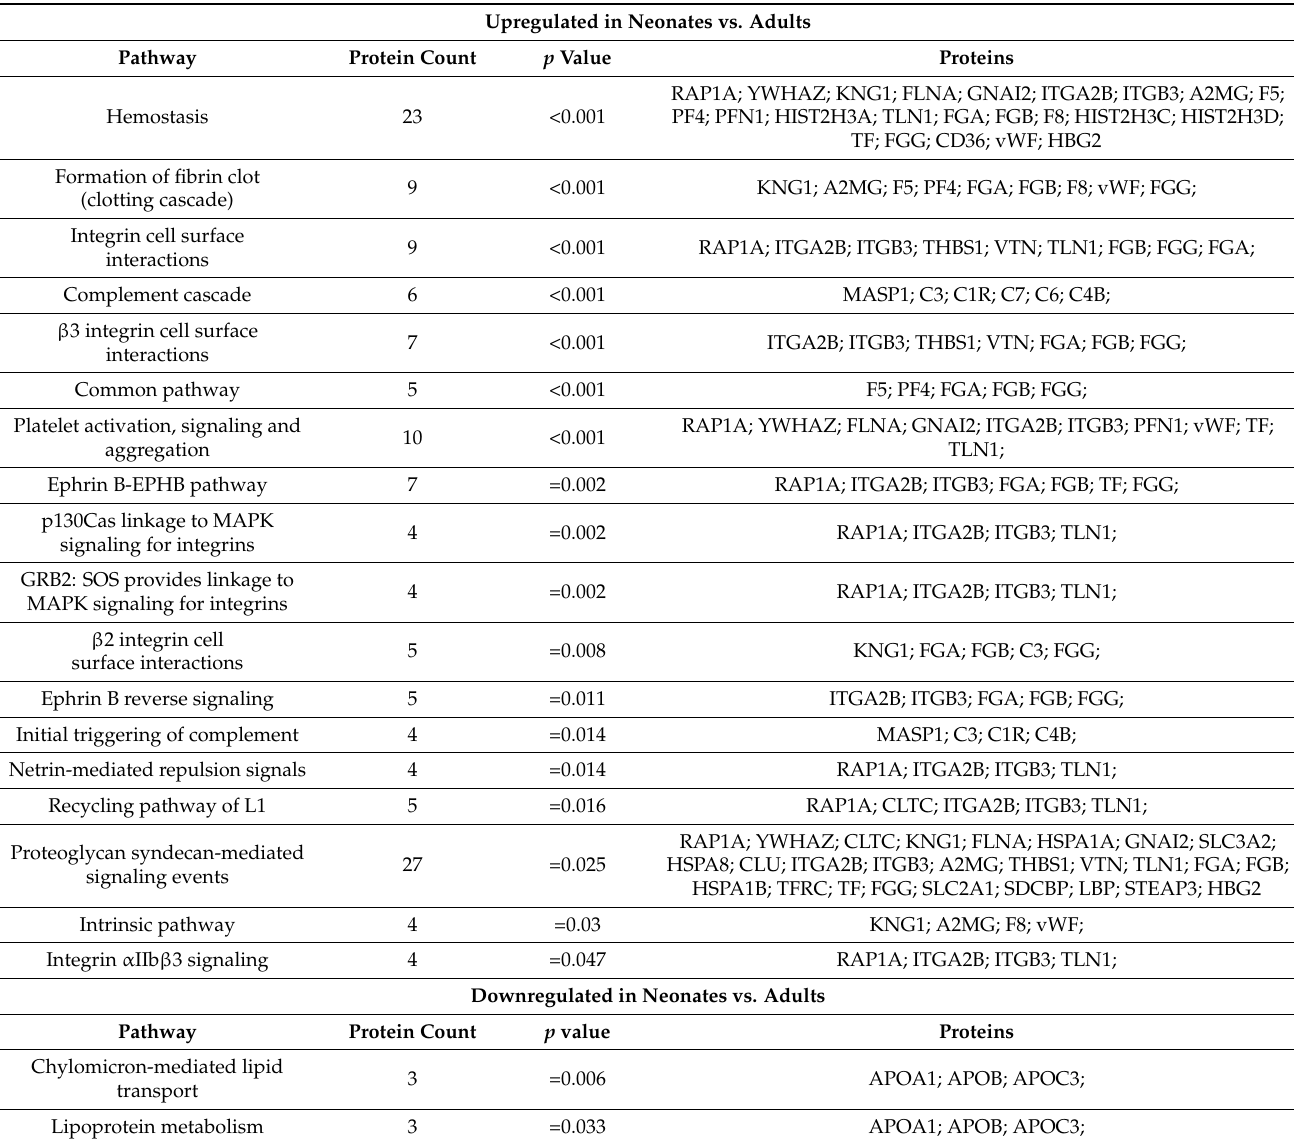
Table 2. Interaction analysis for proteins differentially expressed between neonate and adult exosomes. Upregulated in Neonates vs.